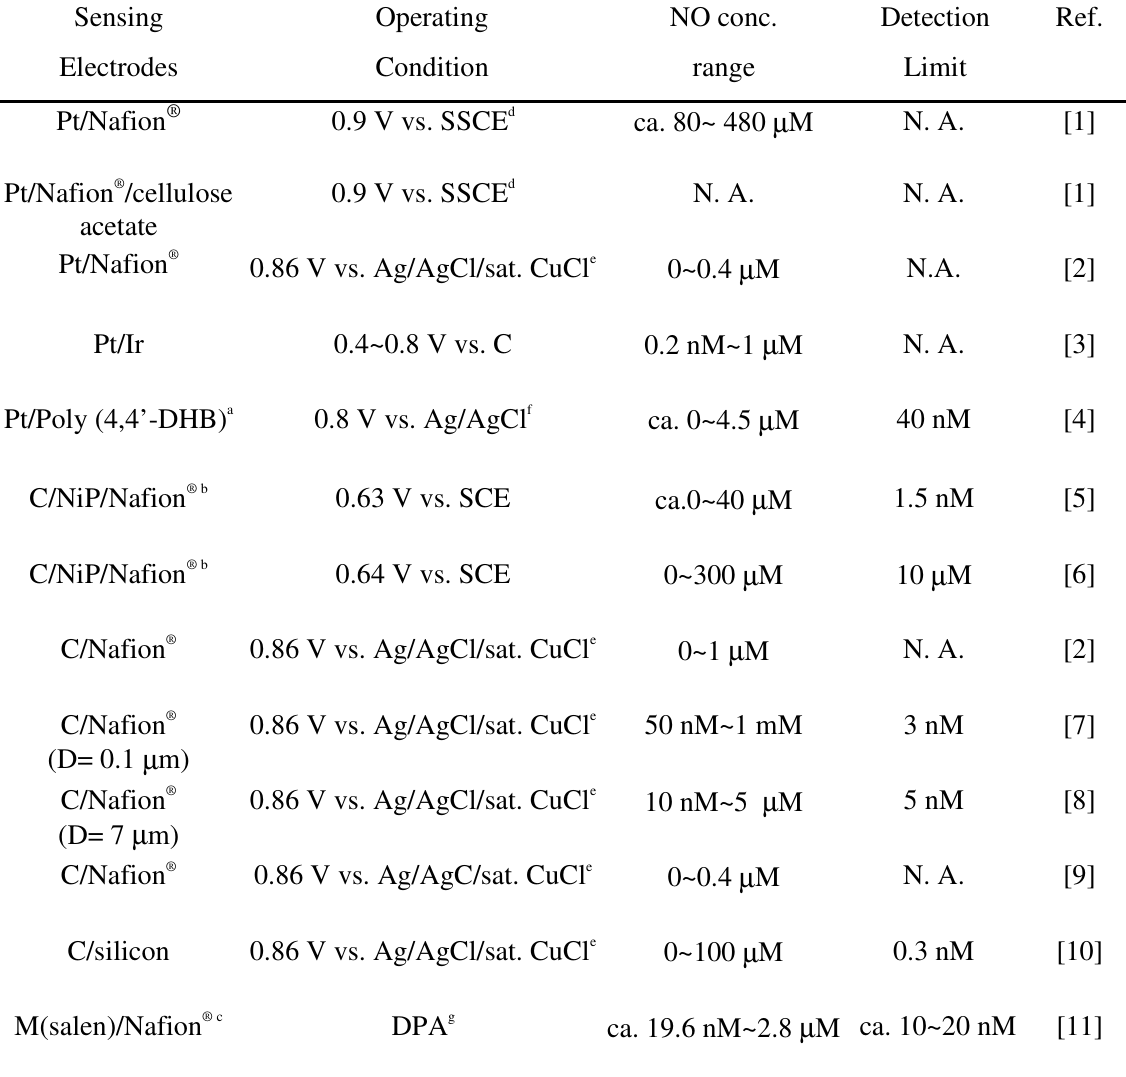
Table 1 . The amperometric operating condition, concentration range, and detection limit for NO sensing studied in the solution phase at various sensing